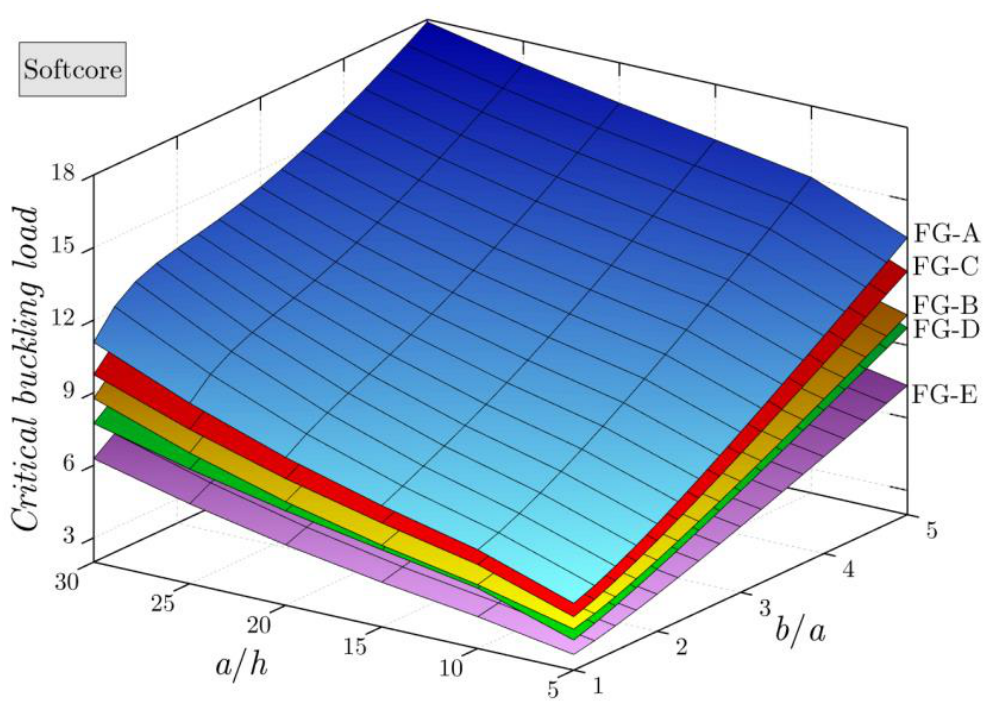
Figure 7. Effect of the shell geometry on the dimensionless critical buckling load 𝑁̅ of coated FG shells (𝑆𝑆𝑆𝑆, 𝑅 = 5, 𝑝 = 𝑘 = 𝑒 = 2, 𝑏 = 𝑎 = 10ℎ, 𝜇 = 𝜆 = 𝐺